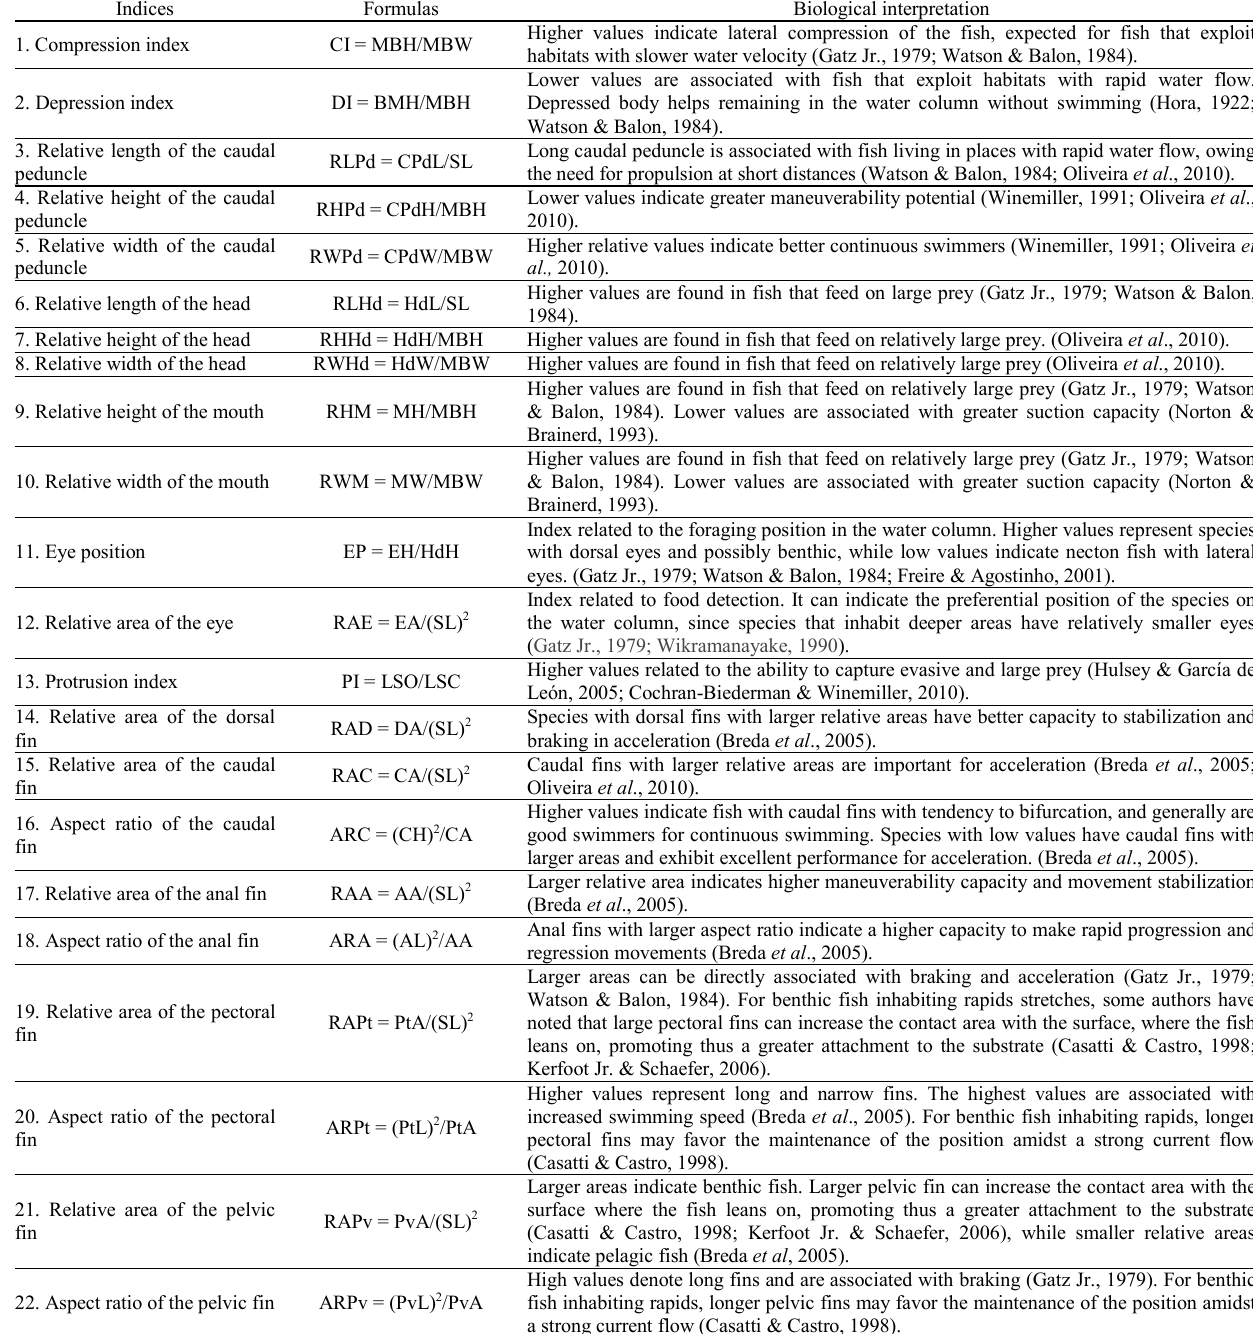
Table 2. Ecomorphological indices with respective formulas and biological interpretations. Formulas include the following measurements: standard length (SL), maximum body height (MBH), body midline height (BMH), maximum body width (MBW), caudal peduncle length (CPdL), caudal peduncle height (CPdH), caudal peduncle width (CPdW), head length (HdL), head height (HdH), head width (HdW), length of snout with the mouth closed (LSC), length of snout with the mouth open (LSO), eye height (EH), mouth height (MH), mouth width (MW), caudal fin height (CH), anal fin length (AL), pectoral fin length (PtL), pelvic fin length (PvL), eye area (EA), dorsal fin area (DA), caudal fin area (CA), anal fin area (AA), pectoral fin area (PtA), pelvic fin area